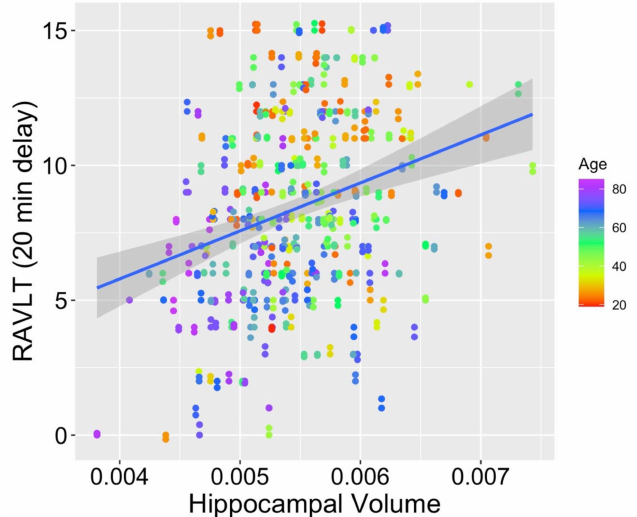
Figure 2. Scatterplot depicting memory score, age, and hippocampal volume. Note: scatterplot depicts novel integration of age, memory score, and hippocampal volume within a single model. The full age range of our sample (19–85 years) is depicted in this Figure, with data from participants aged under 20 years appearing in darker red colors and data from participants aged above 80 years appearing in brighter